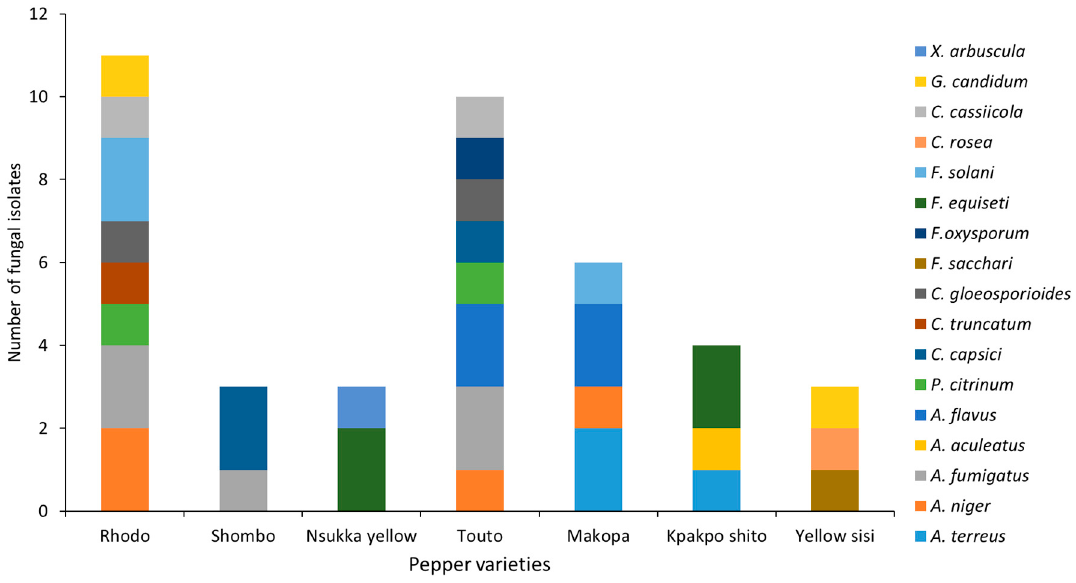
Figure 2. Fungal distribution among the most common pepper varieties collected from retail markets. Table 1. Mycotoxigenic capacity of fungi isolated from fresh peppers.